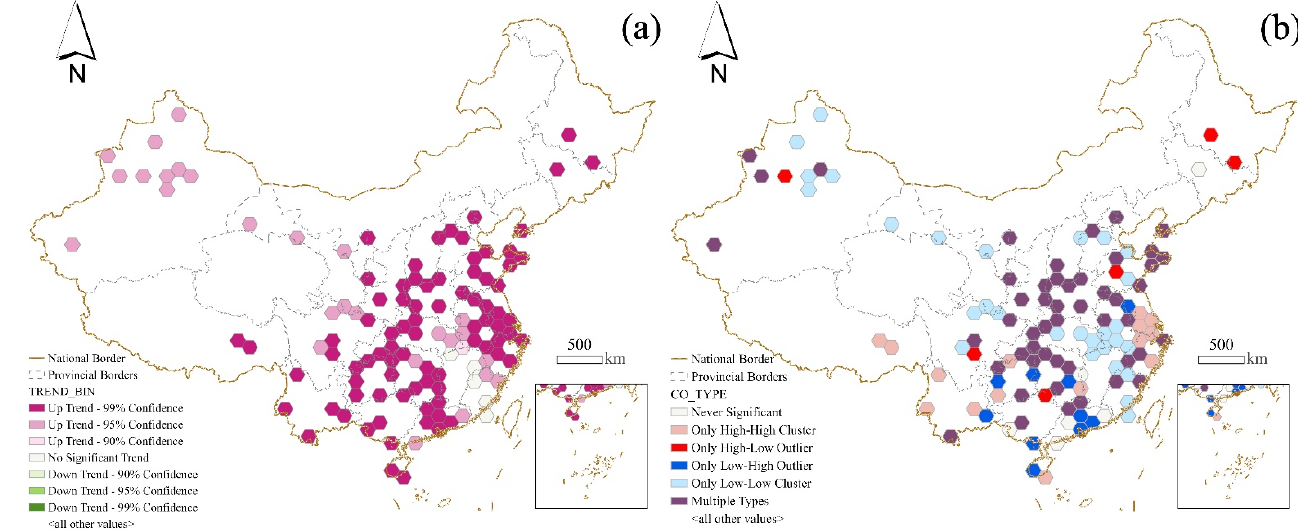
Figure 6. Distribution of trends in tourist sentiment ( a ) and local abnormalities in sentiment ( b ).